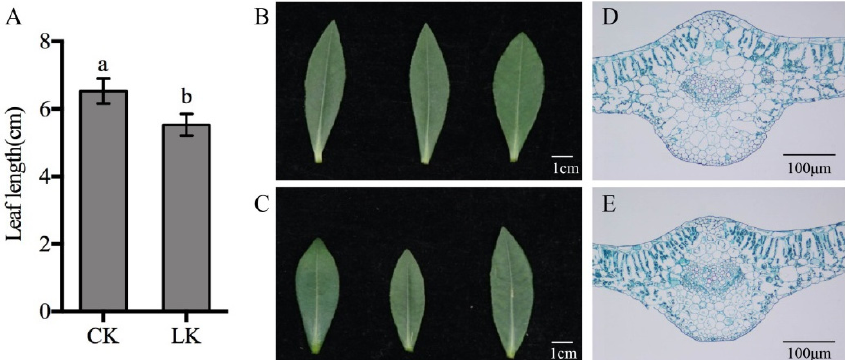
Figure 1. Morphological and microstructural characteristics of alligator weed leaves under different potassium conditions. Note ( A ) statistical results of leaf length; ( B ) leaves from CK; ( C ) leaves from LK; ( D ) leaf microstructure under CK conditions; ( E ) leaf microstructure under LK conditions. Values are the mean ± SD ( n = 3), and different letters indicate significant differences ( p < 0.05) between the treatments, CK indicates control, LK indicates potassium deficiency.